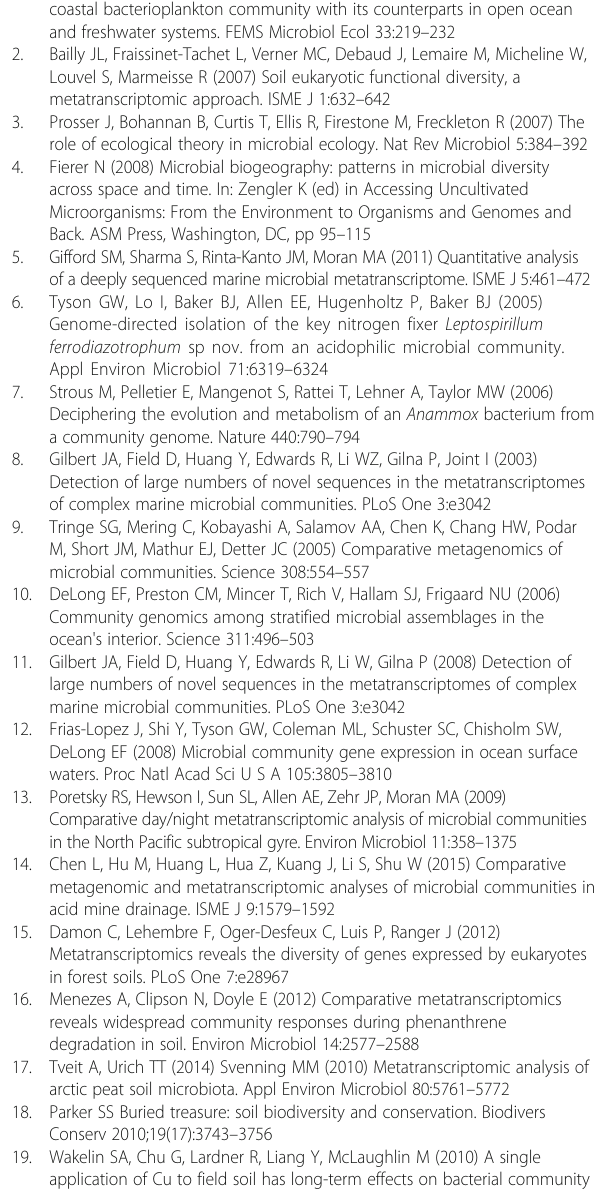
Additional file 1: Fig. S1 . Phylogenetic analysis of upregulated amoC genes obtained using neighbor-joining clustering method having bootstrap values out of 1000 replicates using MEGA 7.0 using UniProt ID with their species and gene name (GN). K0IHK8_ Nitrososphaera gargensis